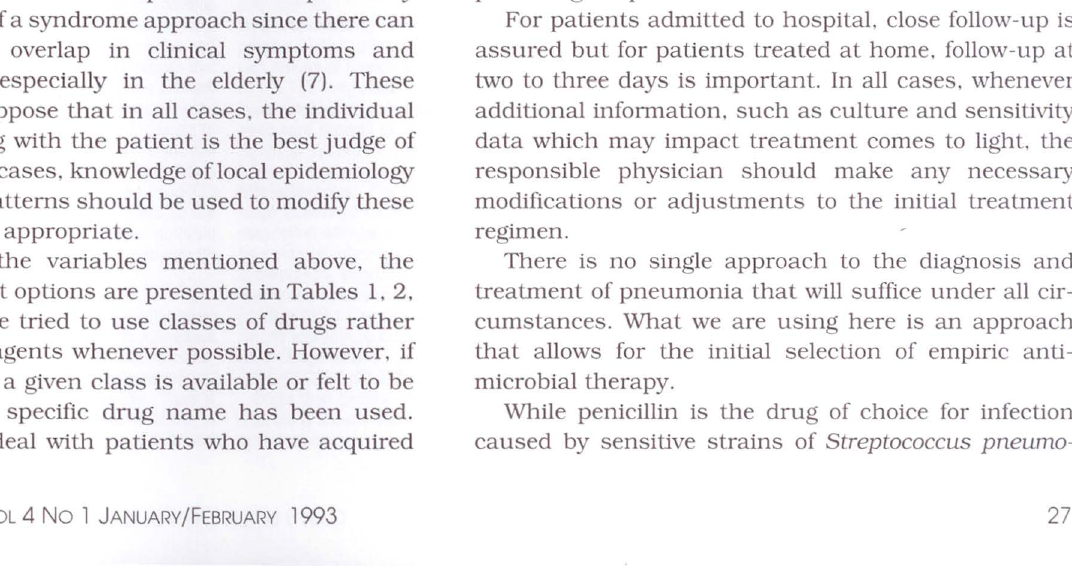
Treatment options for nursing home acquired pneumonia Clinical presentation -